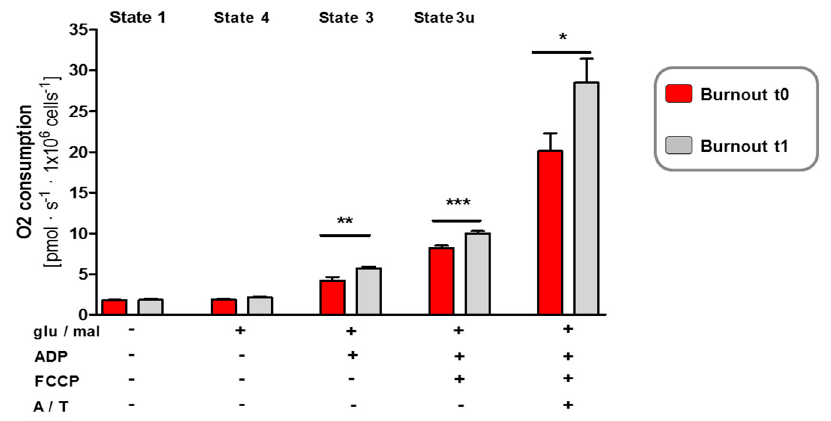
Figure 3. Beneficial e ff ects of physical exercise on mitochondrial respiration in individuals with burnout. High-resolution respiratory measurement reveals an improvement in the mitochondrial oxidative phosphorylation system (OXPHOS) in mitochondria from individuals with burnout at study end. After detection of endogenous respiration (state 1), the mitochondrial substrates glutamate and malate (glu / mal) were added to induce state 4 respiration. ADP stimulated state 3 respiration. After determining coupled respiration, FCCP was added and the maximal respiratory capacity measured in the absence of a proton gradient. Complex IV activity was stimulated by ascorbate / TMPD (A / T). Two-way ANOVA revealed that the total cellular respiration (O 2 consumption) significantly increased in the burnout group after physical activity compared to that at baseline before the intervention: e ff ect of physical exercise p = 0.0015. Post-hoc Student’s t -test analysis: * p = 0.0355, ** p = 0.0046, *** p = 0.0005. Values are represented by the mean ±